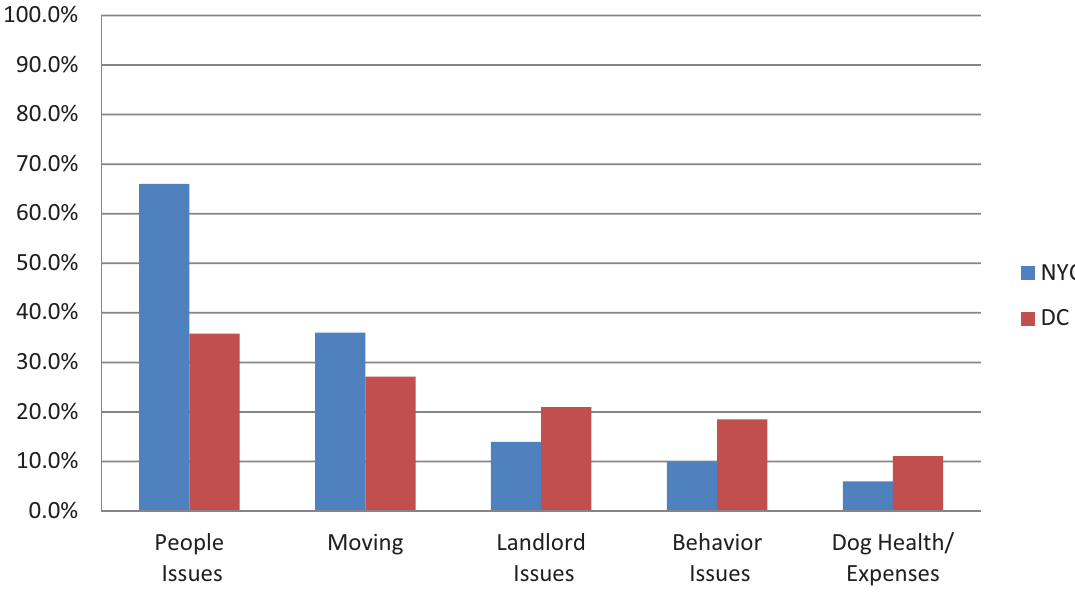
Figure 3. Comparison of factors that influence the relinquishment of large dogs in New York City and Washington,